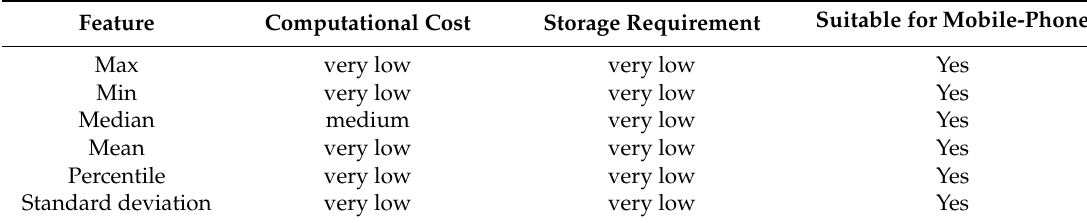
Table 4. Features and their computational